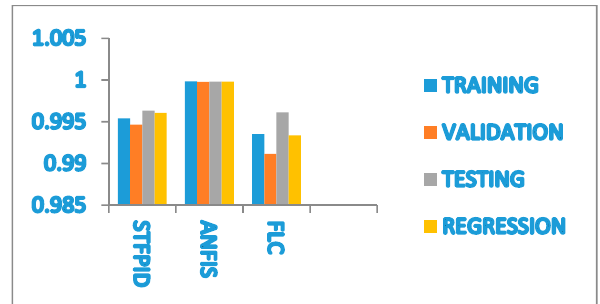
Figure 28. Results of PID after NN optimization.